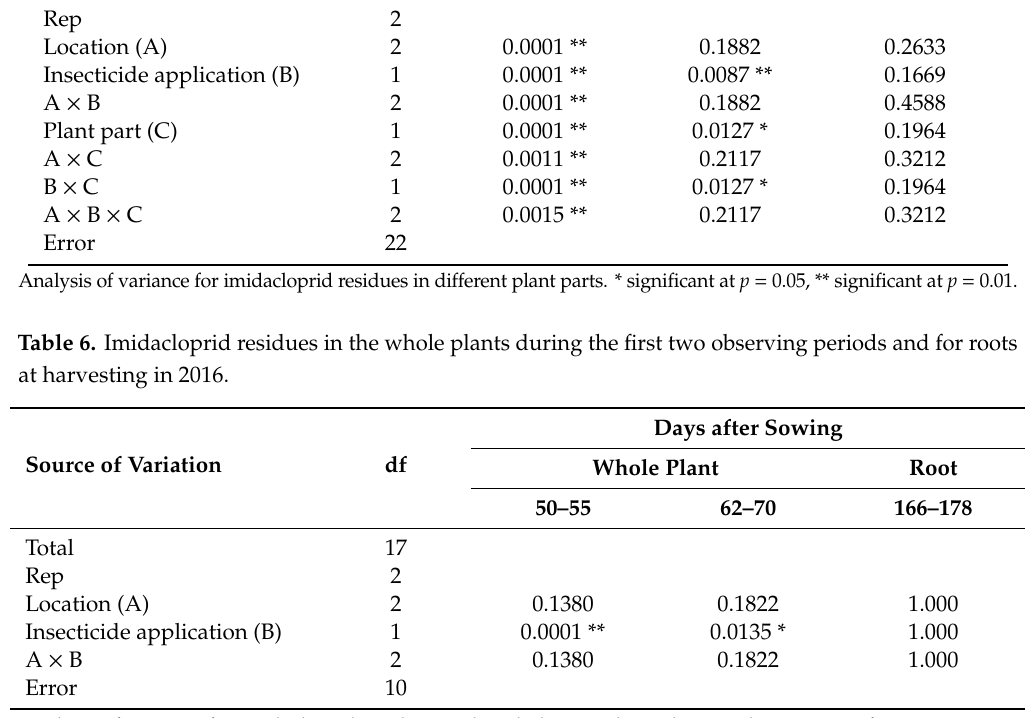
Analysis of variance for imidacloprid residues in the whole sugar beet plants and root. * significant at p = 0.05, ** significant at p =